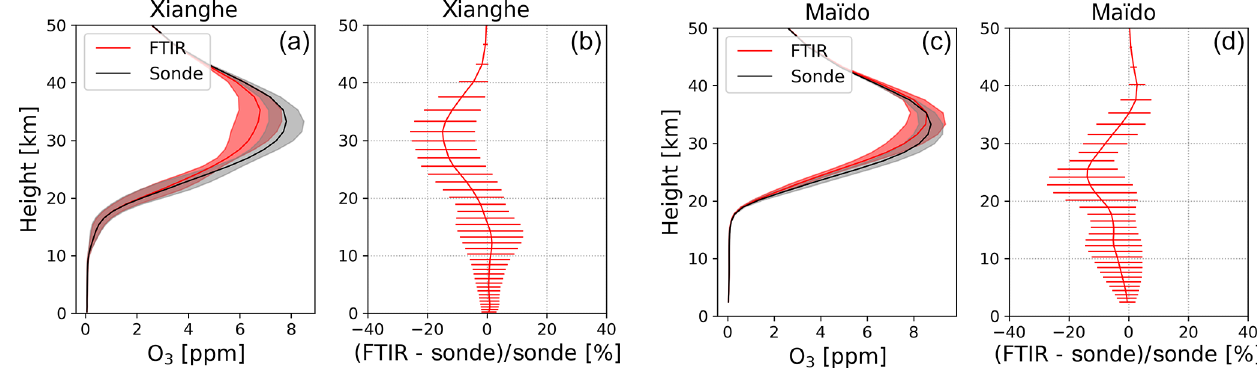
Figure 4. The O 3 profiles from the smoothed ozonesonde and FTIR retrievals (the solid line is the mean and the shading is the SD), together with their relative differences (the solid line is the mean and the error bar is the SD) at Xianghe (a, b) and Maïdo (c, d) .